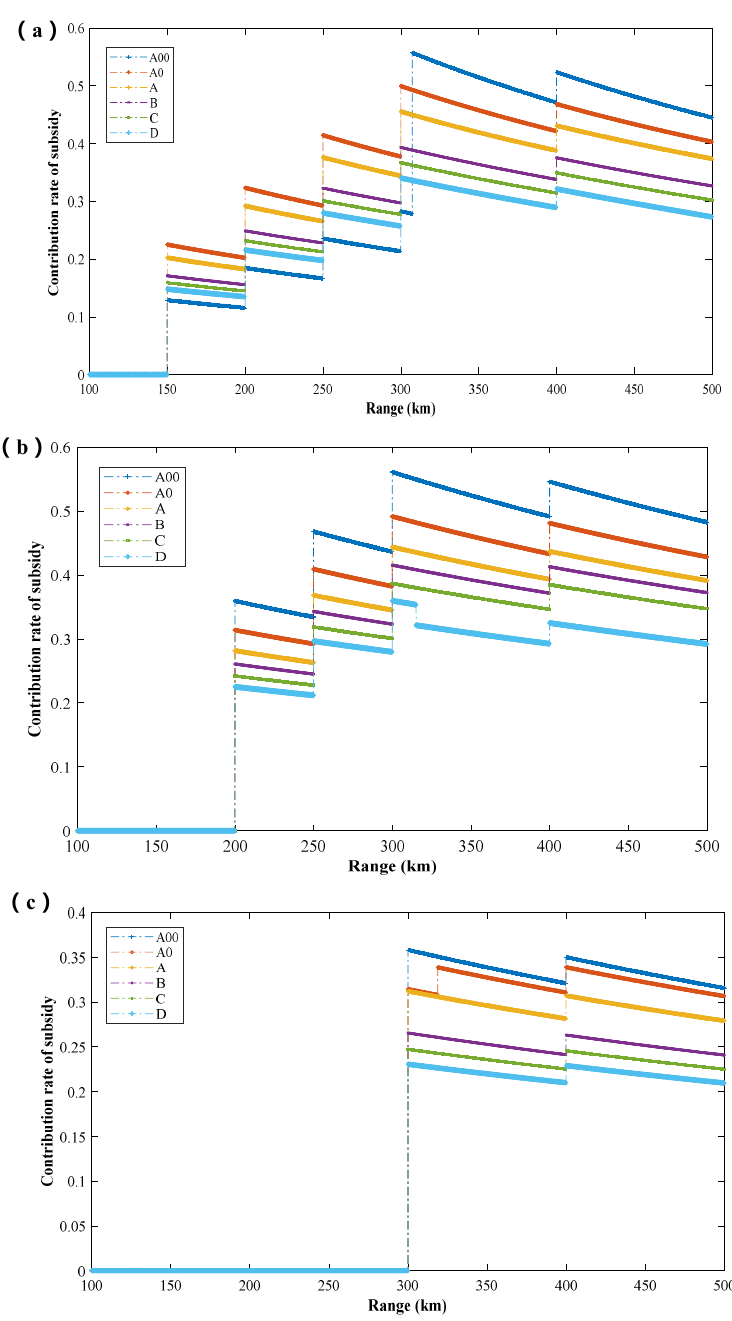
Figure 5. ( a – c ) The contribution rate of subsidy in 2018, 2020, and 2025.